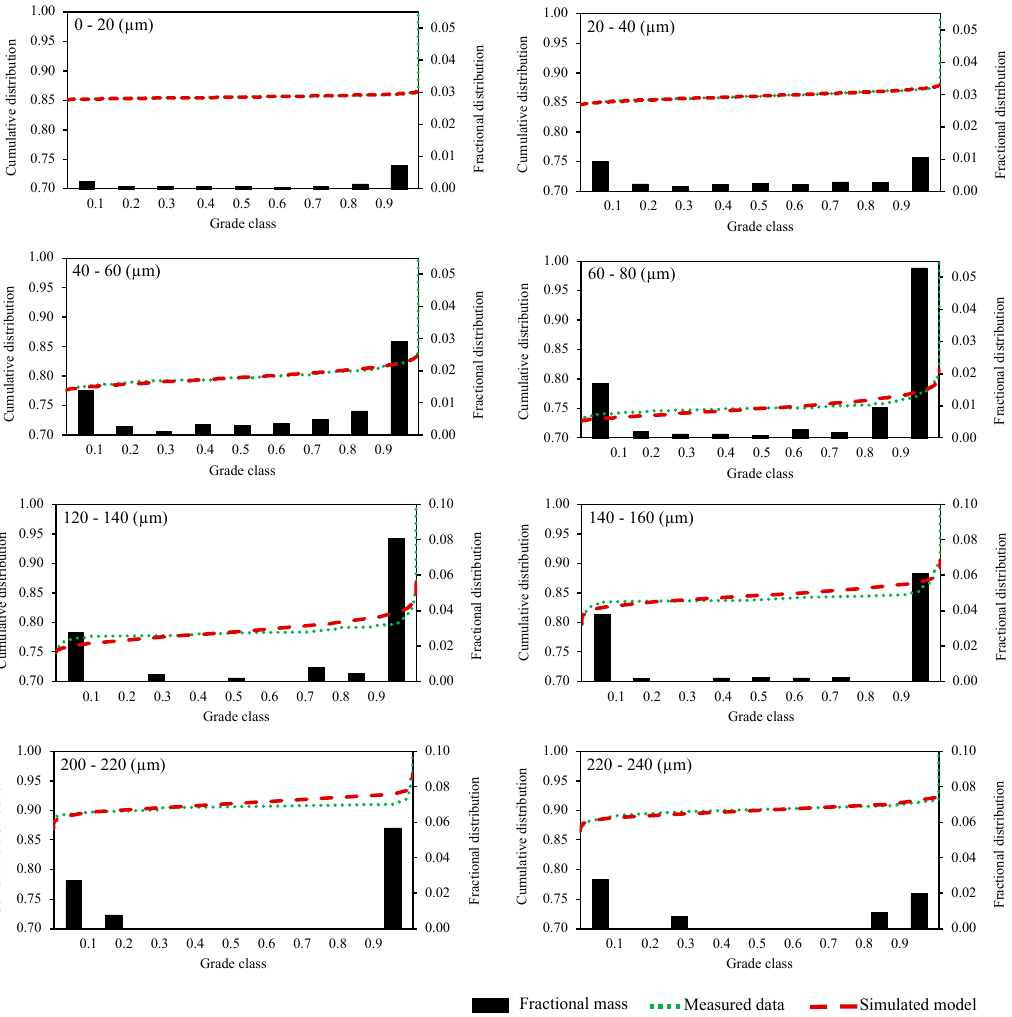
Figure 9. Cumulative distribution vs. grade class of ore for eight cases in different particle sizes. The difference between the simulated and experimental data is shown.